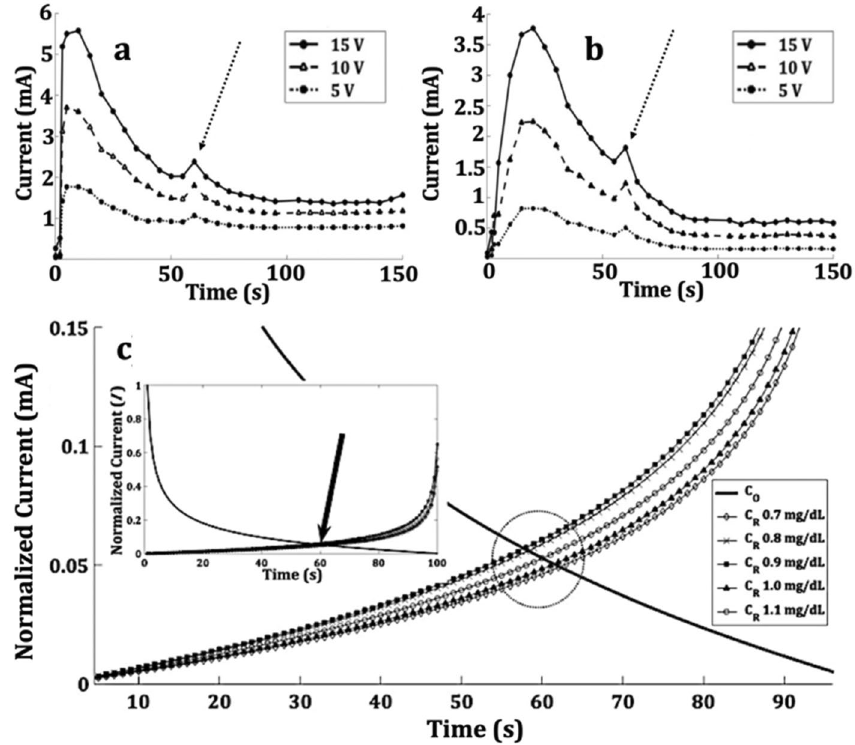
Figure 6. Response time of 3BOBzBT 2 :5CHCl 3 -sensor at 15 V, 10 V and 5 V for ( a ) 0.7 mg dL −1 creatinine concentration, ( b ) 1.2 mg dL −1 creatinine concentration. ( c ) Graph of normalised current obtained by solving Eq. (1) represented by smooth curve and Eq. (2) represented by marked curves for t → ∞ . The arrow indicates that the intersection between C O and C R which is coincided with a spike in ( a ) and ( b ).